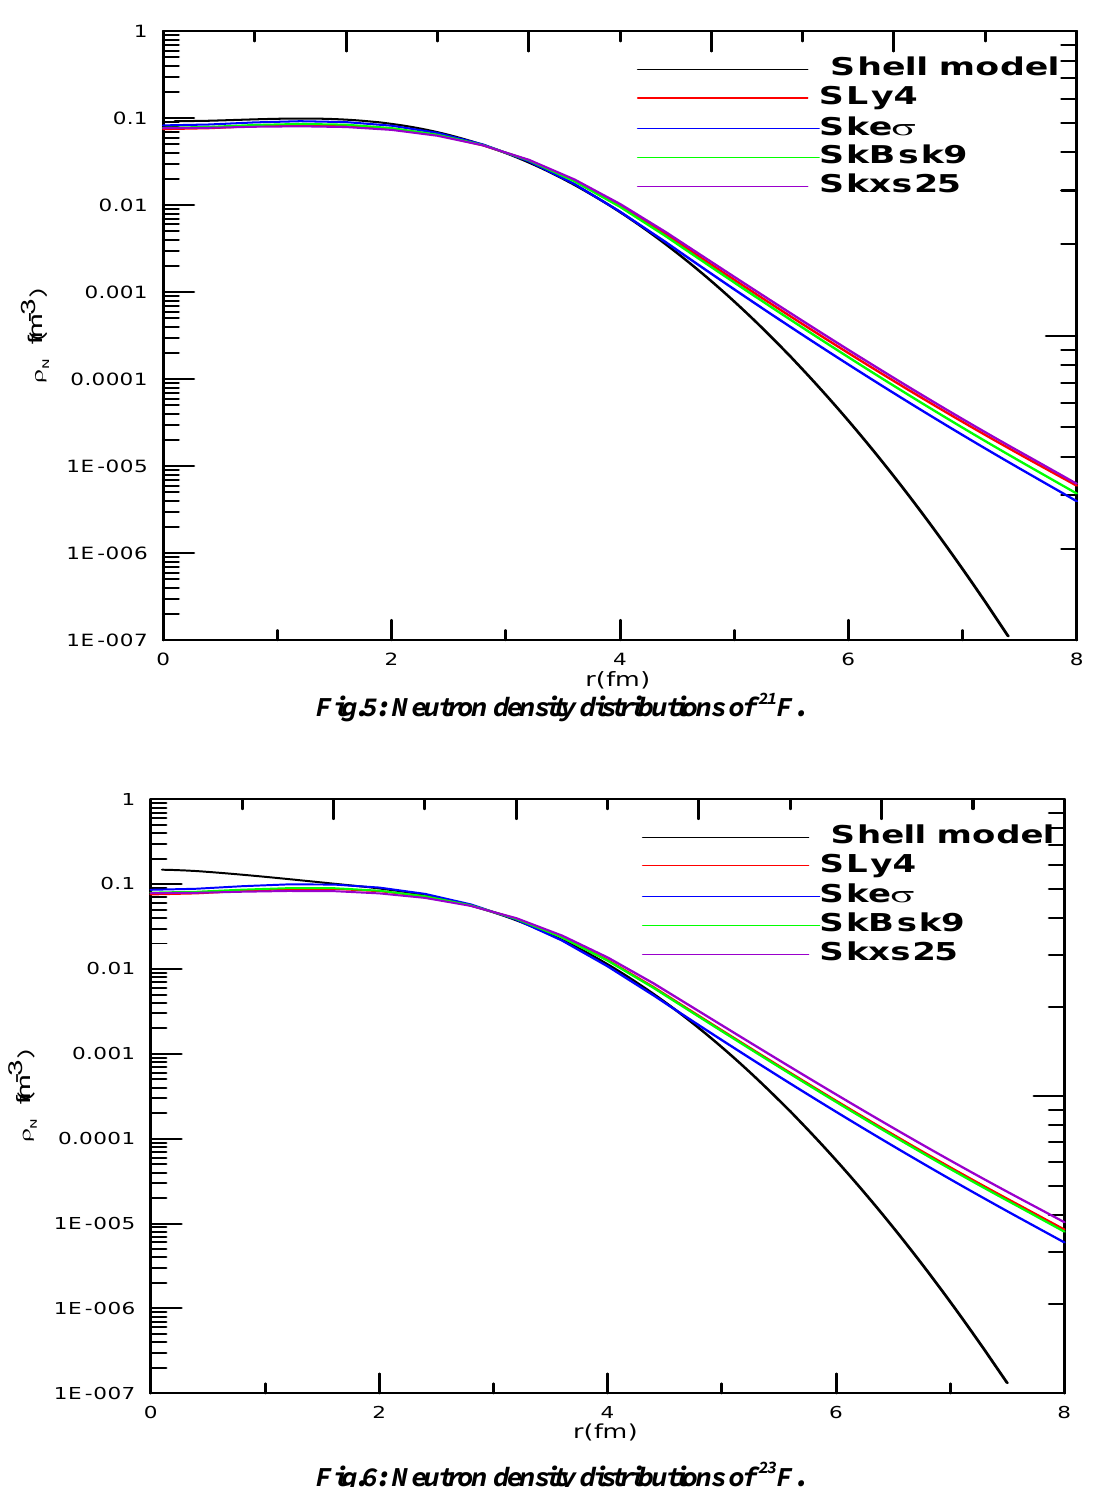
Fig.6: Neutron density distributions of 23